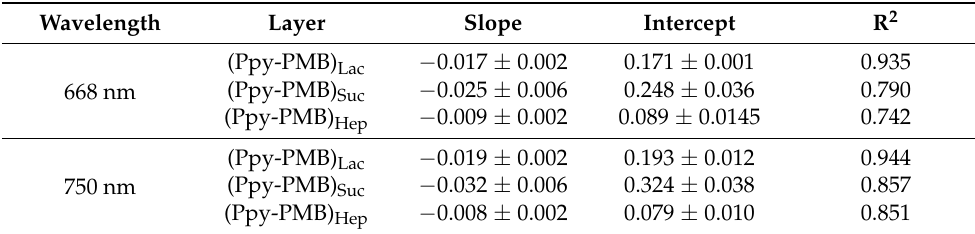
Figure 6. Calibration curve of ∆ A (at the wavelengths of: ( A )— λ = 668 nm and ( B )— λ = 750 nm) as function of the pH value of BRB with 0.1 M of KCl solution, when potential pulses were of +0.8 V and –0.8 V with duration of 10 s. Each potential pulse was repeated for 5 times. Table 1. Dependence of absorbance changes (at λ = 668 nm and λ = 750 nm) on the pH of BRB solution. The slope and intercept values of the calibration